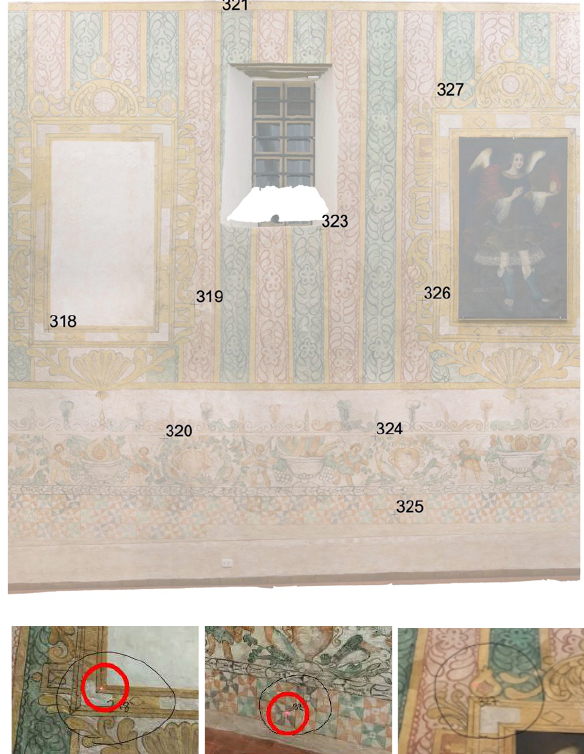
Figure 13 . Upper: Samples of natural control points of the geodetic network on one section of the mural paintings and marked on the ortho-corrected image. Lower: Three reference images of the natural point locations GCP 318, 325, and 327. Images by CIMS © GCI